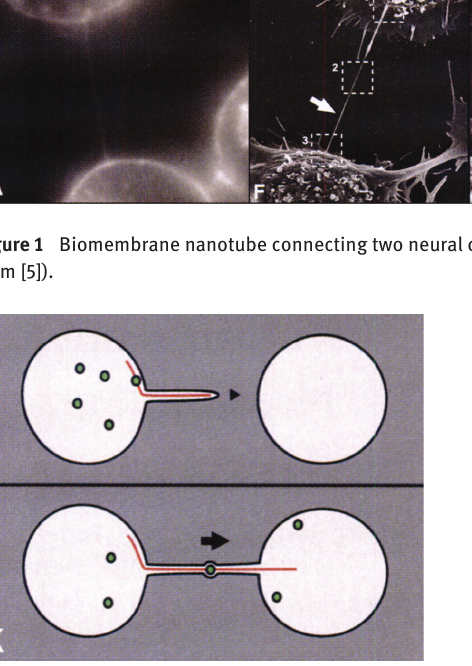
Figure 2 Transfer of organic particles through a membrane nano- tube (cited from [5]).